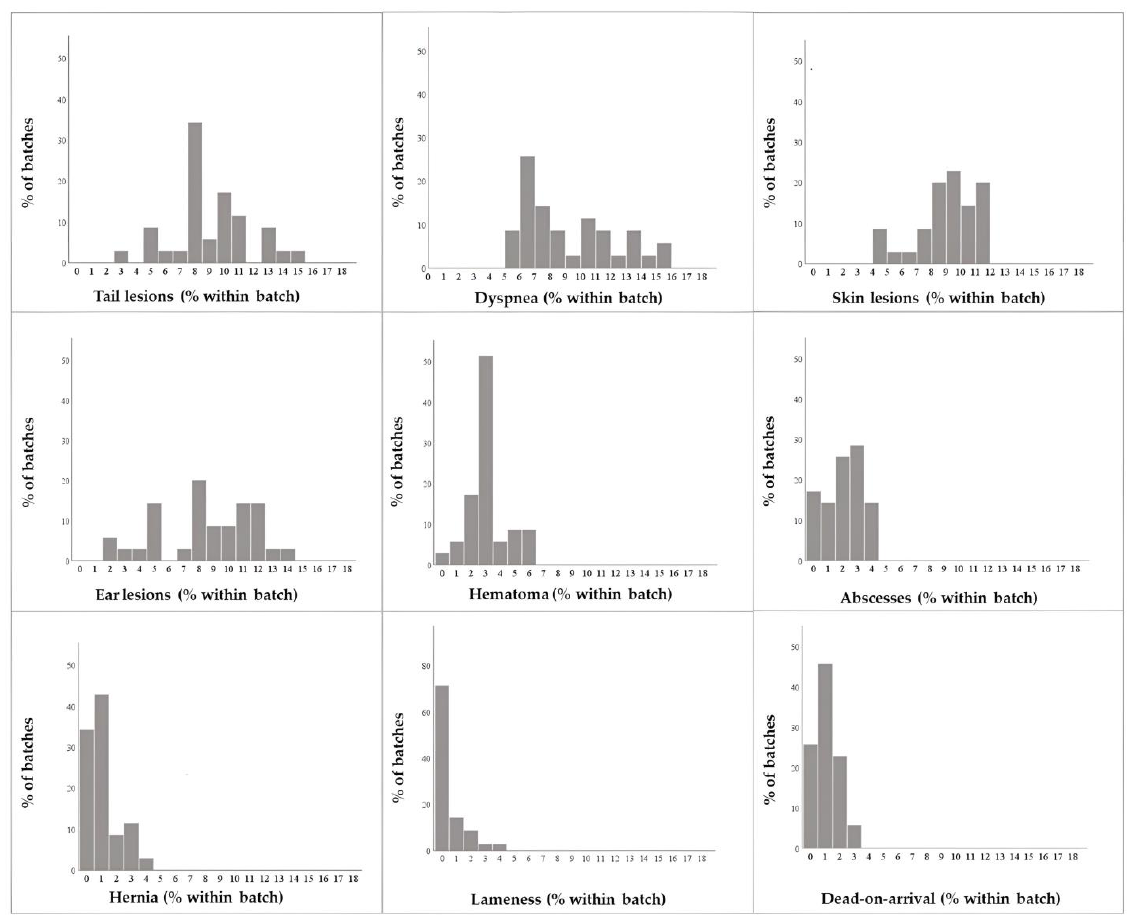
Figure 1. Frequency distributions of within-batch prevalence of ante-mortem conditions/lesions and within-batch mortality dur- ing transport recorded among slaughtered pigs ( N = 35 batches).